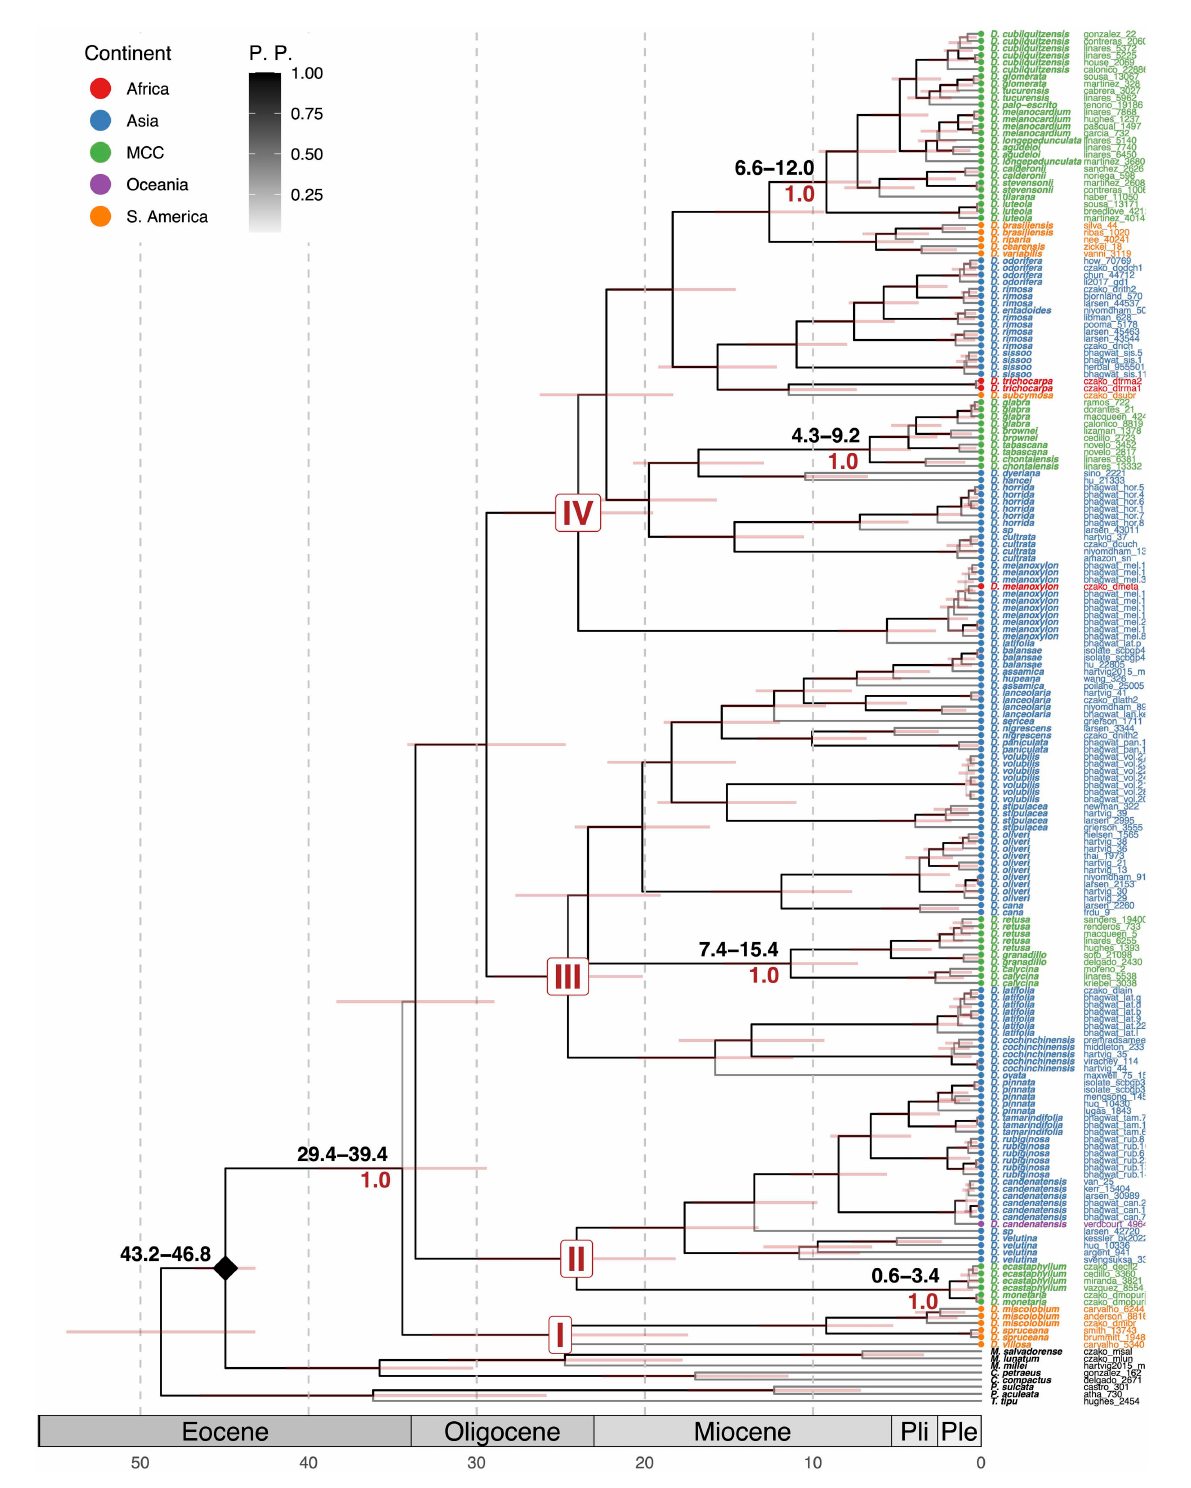
FIGURE2 Combined Bayesian calibrated tree of Dalbergia . Above the branches, the estimated age range of the clades is in black font. Local posterior probabilities are shown under branches in red font. Shading bottom bars represent geological epochs. The diamond mark represents the calibration node. The bars on the branches represent the range of the 95% confidence interval in the Bayesian